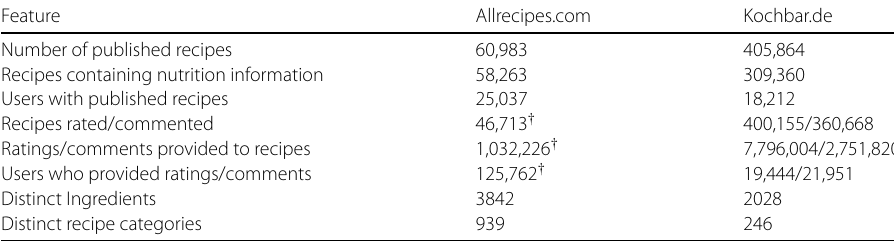
Table 2 Basic statistics of the Allrecipes.com and Kochbar.de dataset Feature Allrecipes.com Number of published recipes